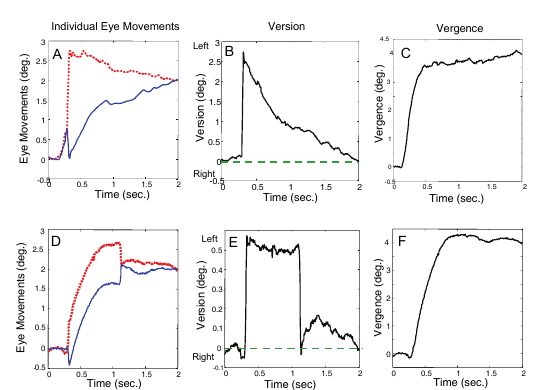
Figure 3 Responses from two subjects to a symmetrical convergent 4.0 deg. step change in stimulus position. In these responses, an early saccade creates a symmetry error. A) and D) Individual left (red dashed line) and right (blue solid line) eye movements showing the presence of saccades along with the vergence response. Convergence is plotted upward for both eyes. B) and E) The version component as defined in Eq. 2. A leftward movement is plotted negative and rightward movement is positive with zero at the mid-sagittal plane. In B, the saccade induced symmetry error is corrected by a slow version movement while in E a second saccade corrects most of the error. C) and F) The vergence behavior obtained as defined in Eq. 1 with convergence plotted upward. Because the saccades have approximately the same amplitude in both eyes they are difficult to observe when combined into a vergence movement.